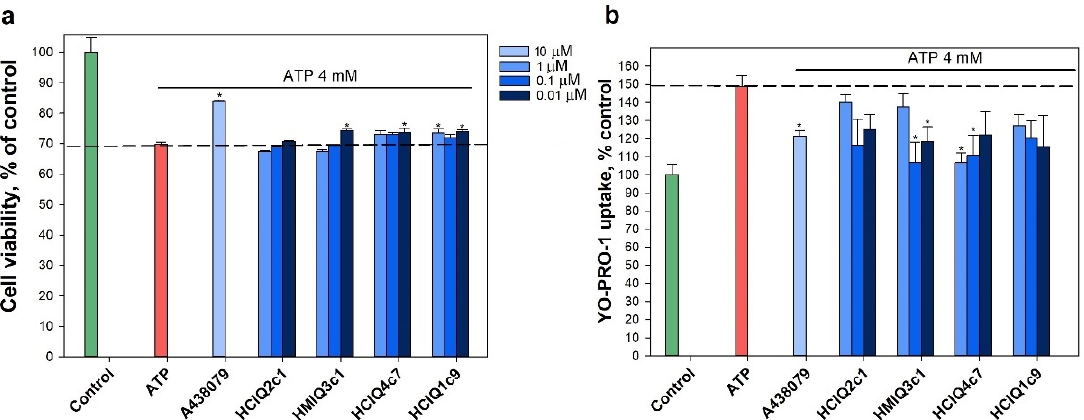
Figure 11. The effects of the peptides on ATP-induced Neuro-2a cell viability and activation of P2X7R. ( a ) Impact of the peptides on Neuro-2a cell viability in the presence of 4 mM ATP. The peptides were tested at concentrations of 0.01, 0.1, and 1.0 µM. Cells were incubated with peptides for 1 h at 37 °C, then for 48 h with ATP. ( b ) Effects of the peptides (0.01, 0.1, and 1.0 µM) on YO-PRO-1 uptake in Neuro-2a cells. ATP was used as a P2X7R agonist. A438079 (10 µM) was used as a standard inhibitor of P2X7R. The peptide effects were evaluated against the effects of ATP. The data are shown as means ± SE; *— p < 0.05 compared to the effect of ATP alone.